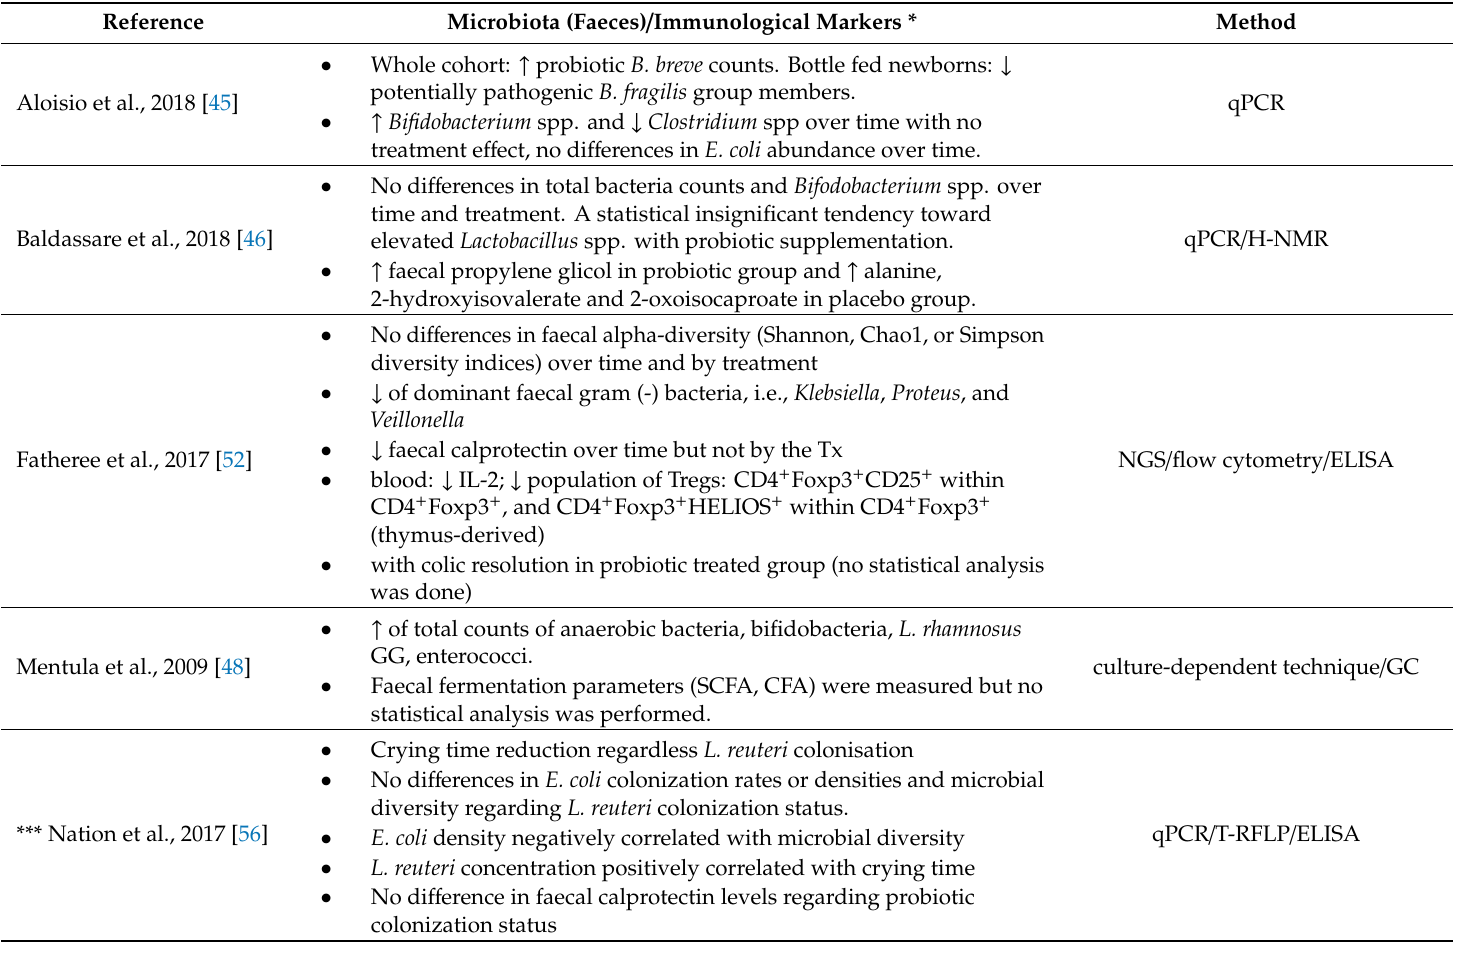
Table 2. Microbiological (compositional and functional) and inflammatory biomarkers a ff ected by